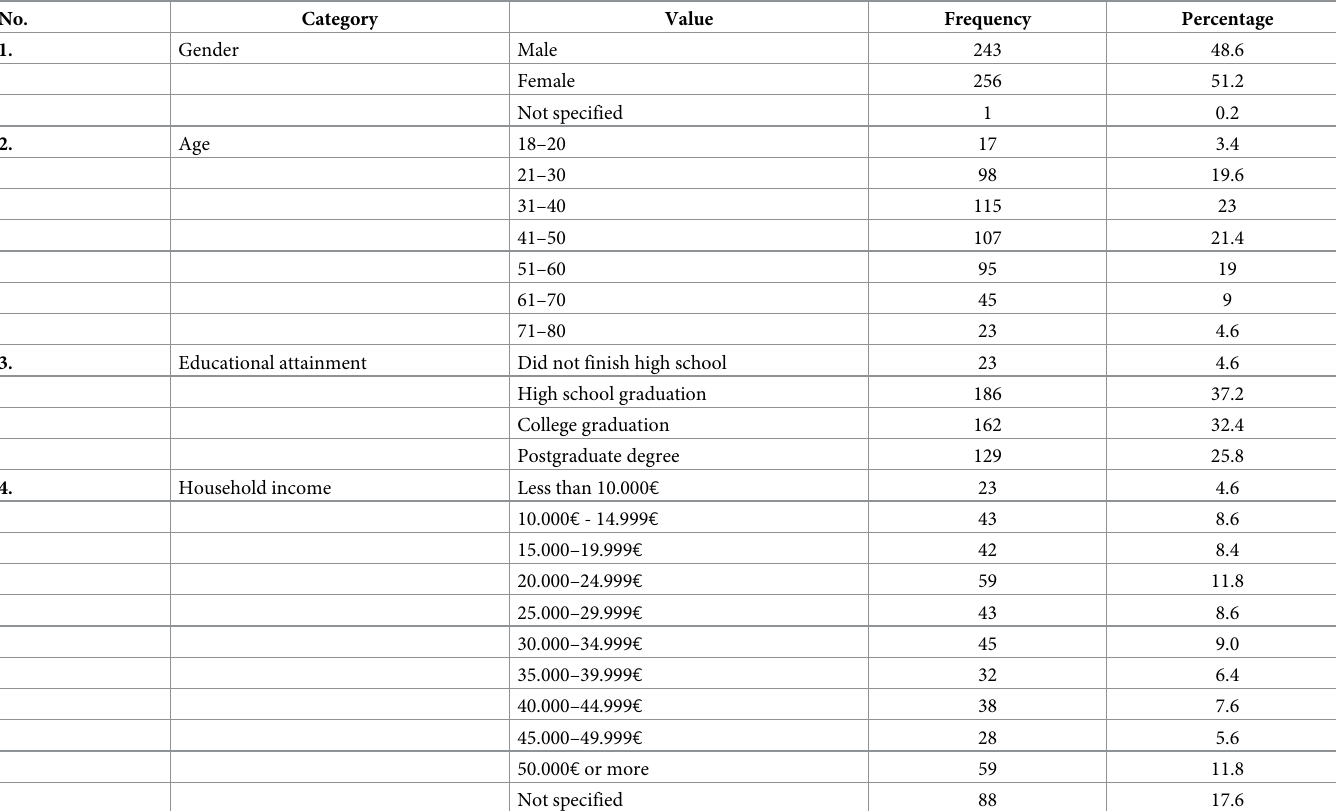
Table 3. Demographics of the sample in Study